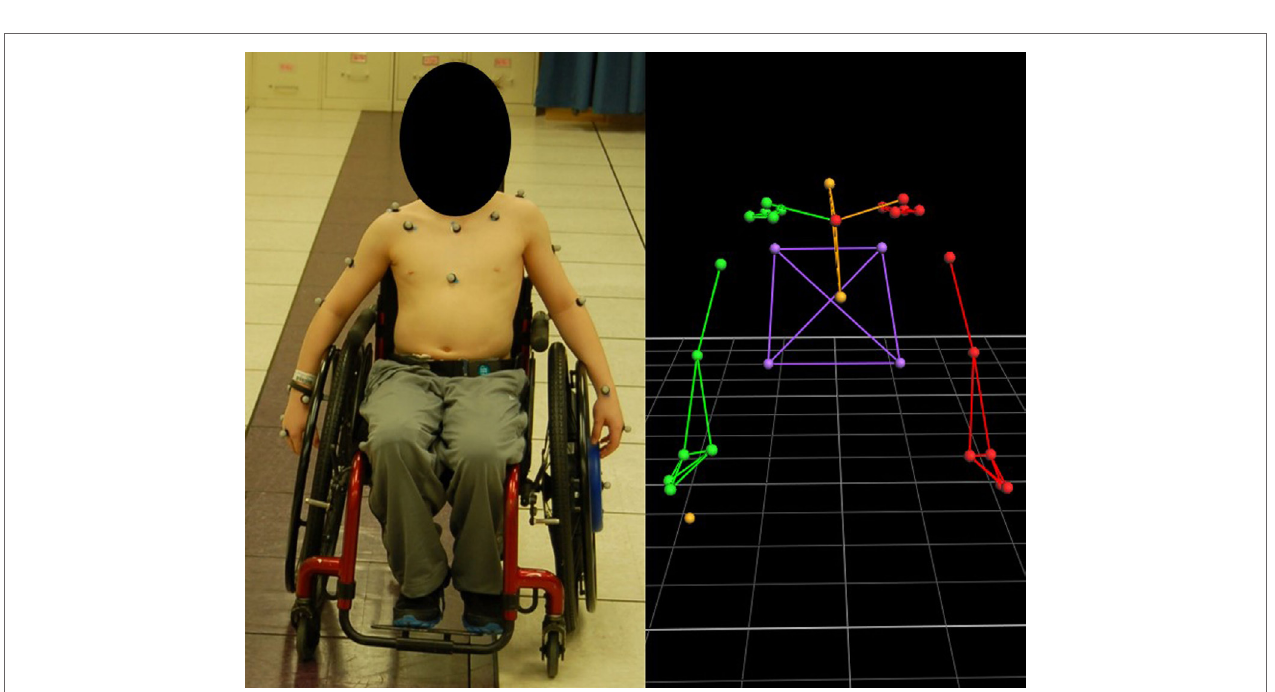
FigUre 1 | subject with marker set applied and smartWheel replacing the dominant, left-hand side wheel (left) and the model rendering in Vicon nexus software .